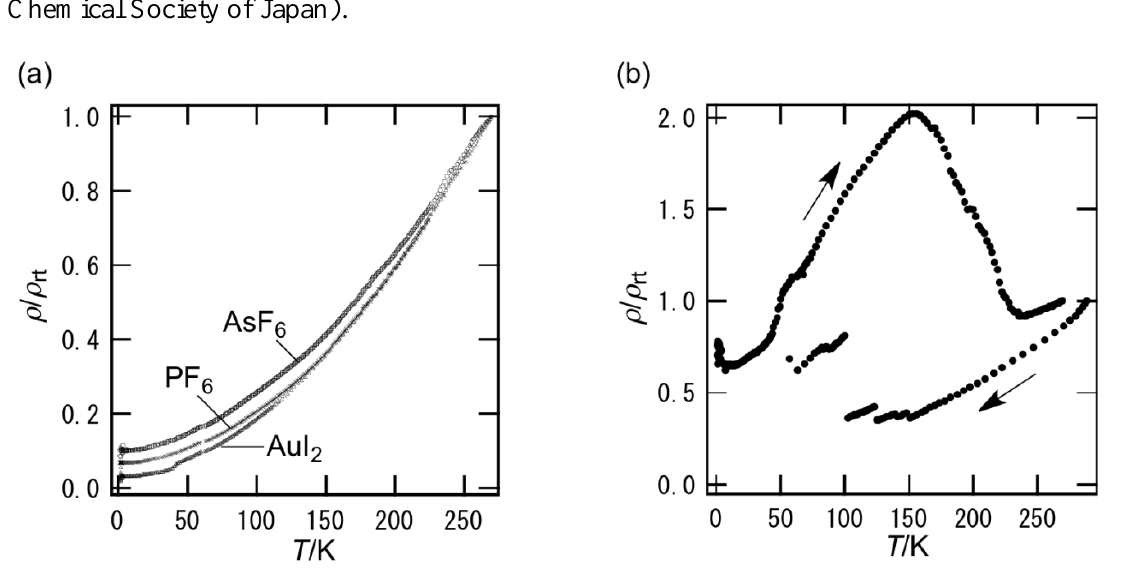
, PF , AsF and 2 6 6